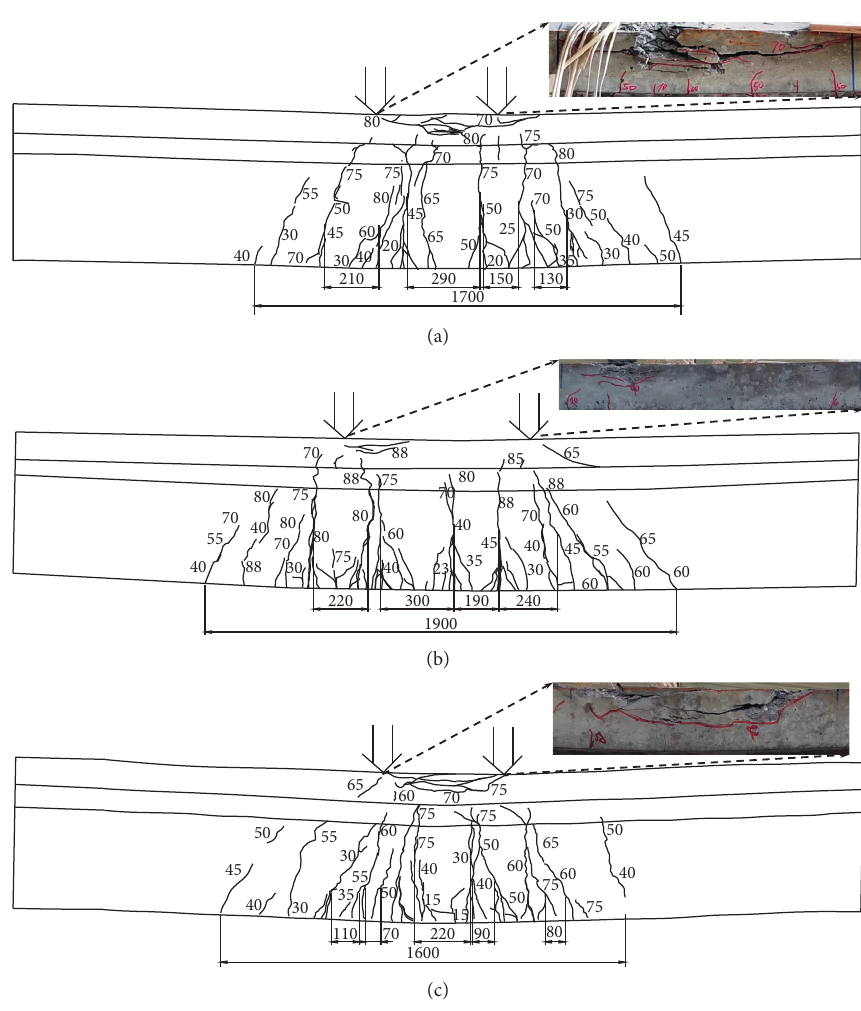
Figure 4: Crack pattern in SP-A, SP-B, and SP-C ( × 10kN). (a) SP-A. (b) SP-B. (c) SP-C.